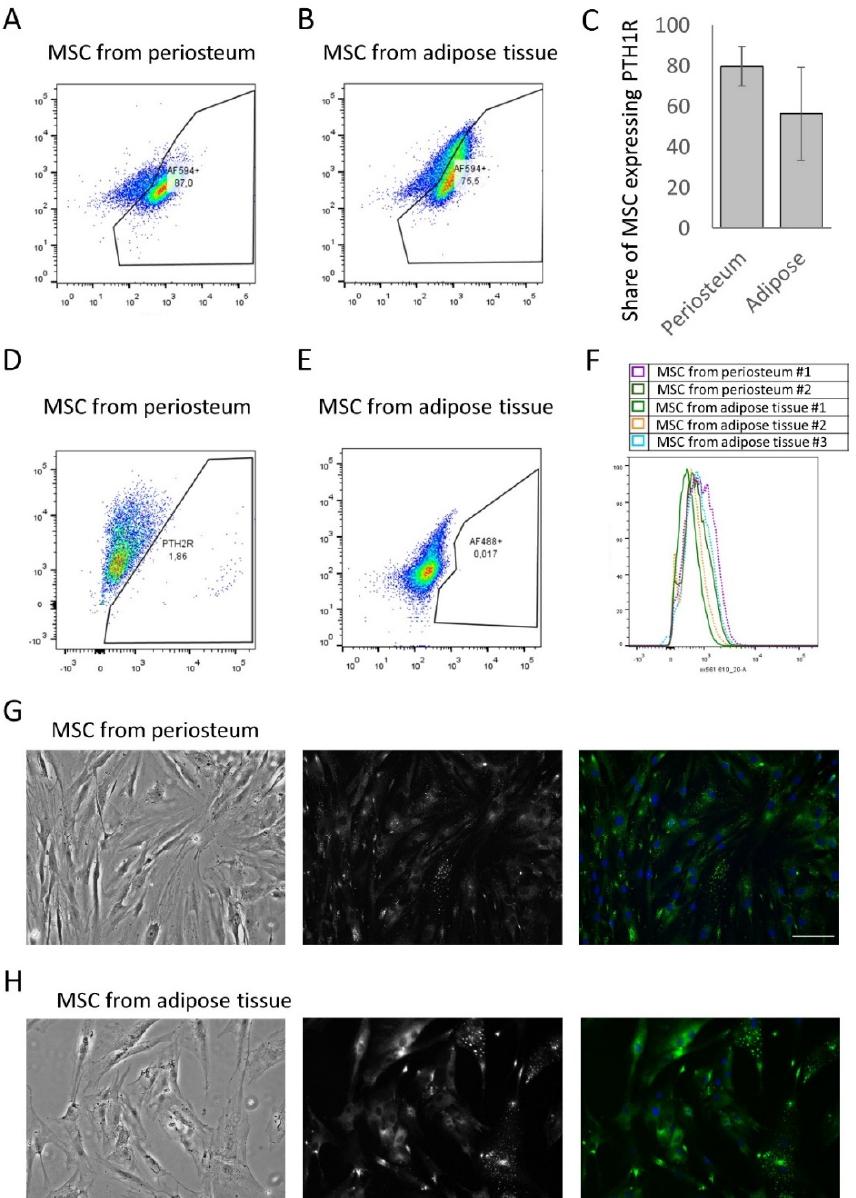
Figure 2. Analysis of PTH1R and PTH2R expression in MSC isolated from periosteum and adipose tissue. ( A , B ) Representative flow cytometry graphs of PTH1R expression in MSC isolated from periosteum ( A ) and adipose tissue ( B ). ( C ) Statistical analysis of PTH1R expression measured by flow cytometry. Mean ± SE, n = 3–4 different donors. ( D , E ) Representative flow cytometry graphs of PTH2R expression in MSC isolated from periosteum ( D ) and adipose tissue ( E ). ( F ) Flow cytometry analysis of PTH1R density on the cell surface of MSC from periosteum and adipose tissue. ( G , H ) Rep- resentative immunofluorescent images of PTH1R expression in MSC isolated from periosteum ( G ) and adipose tissue ( H ) The scale bar represents 500 µ